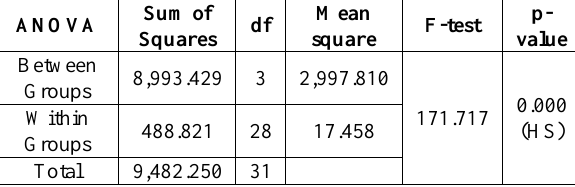
Figure 6: the mean values of the vertical marginal gap of all groups Table 2: One- way ANOVA test among the four conventional impression subgroups .